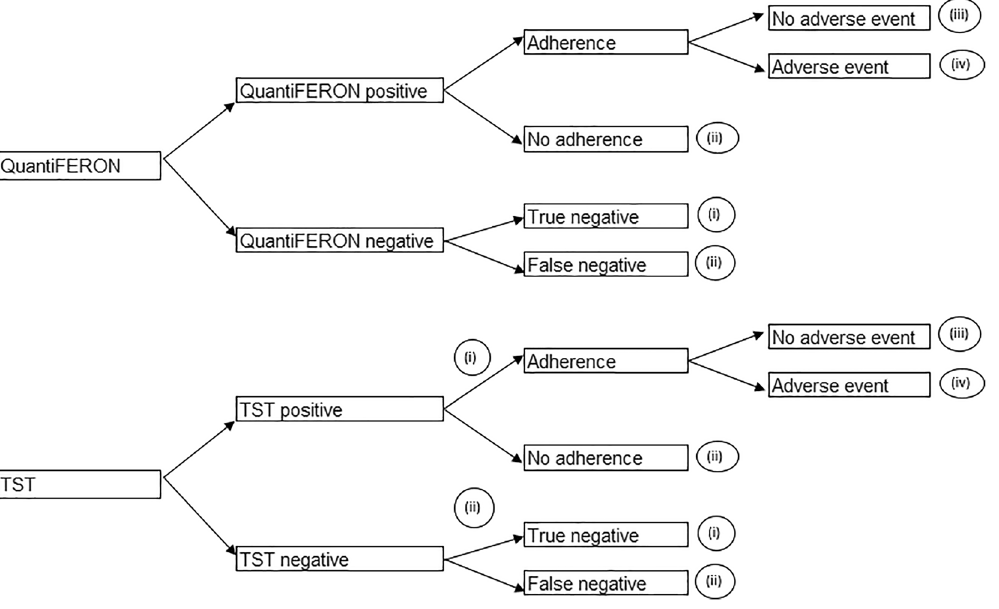
Figure 1. Decision tree structure. The decision tree structure for QuantiFERON-TB Gold Plus (QuantiFERON) and the tuberculin skin test (TST). The four health states leaving the decision tree are (i) Healthy, (ii) Untreated latent tuberculosis infection (LTBI) (treatment Naïve), (iii) LTBI, taking treatment without adverse events and (iv) LTBI, taking treatment with adverse